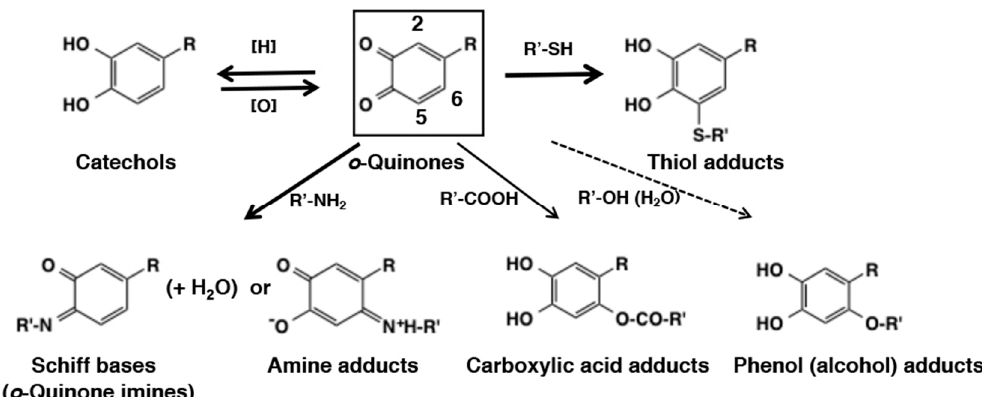
Figure 4. Summary of intrinsic chemical reactivity of o -quinones. The relative reactivity is shown in the thickness of the arrows. Note that the reactions with carboxylic acids and alcohol (water) are possible only when the functional groups are present in the side chain of o -quinones. For the sake of simplicity, the numbering on the o -quinone ring is made so that R- is attached to the C1 position. The addition of thiols proceeds mostly at the C5 (major) and C2 (minor) positions (1,6-Michael addition) while the addition of other nucleophiles proceeds mostly at the C6 position (1,4-Michael addition).